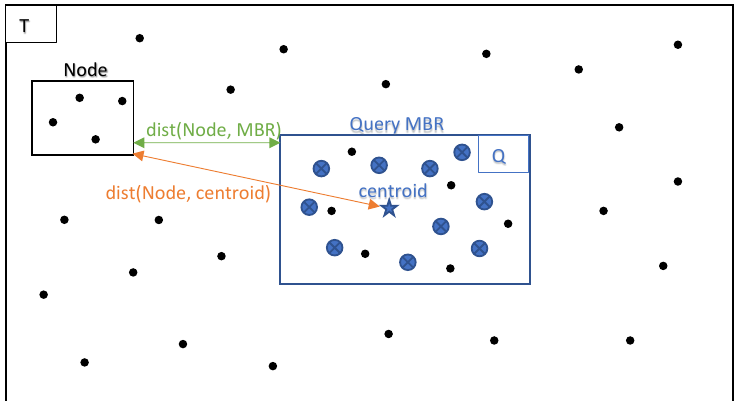
Figure 4. Query MBR and arbitrary node.